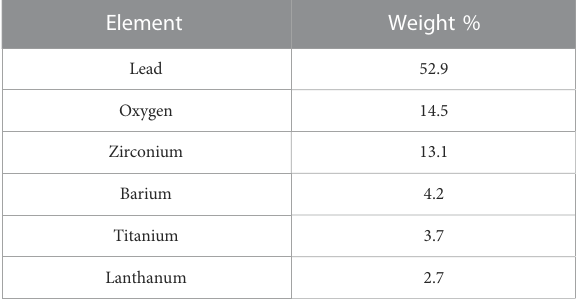
TABLE 1 Chemical composition of PZT using EDAX analysis reproduced from the study by Praveen et al. (2018).